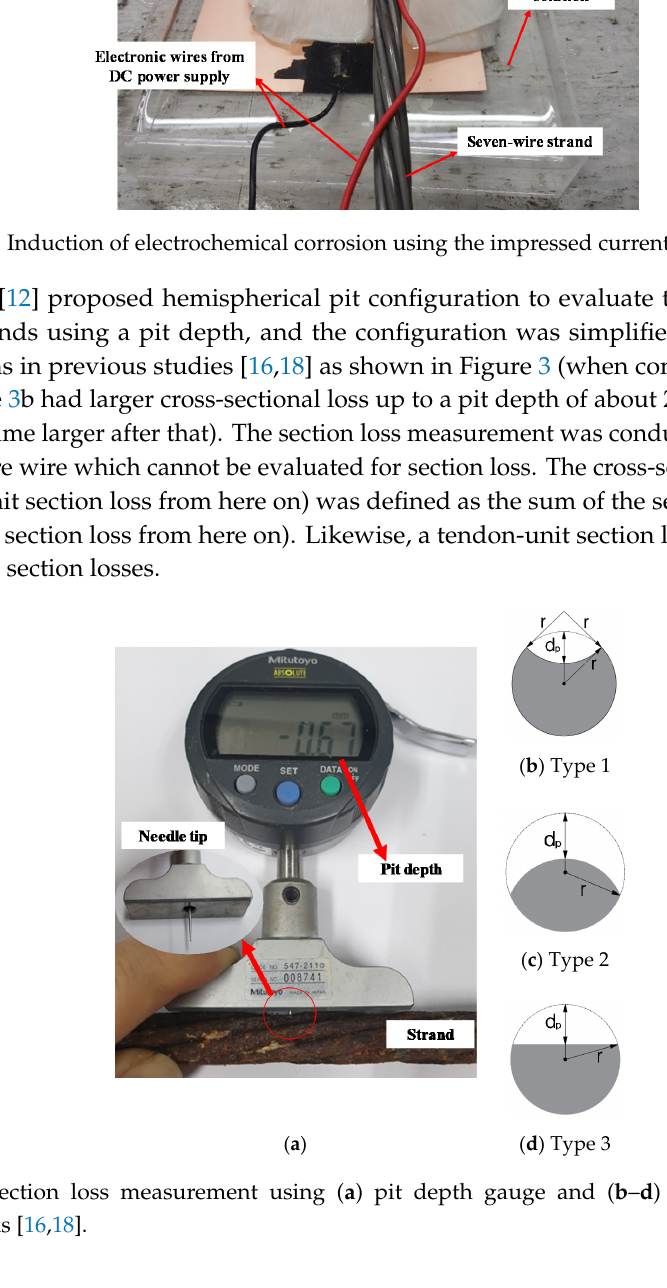
Figure 1. Detailed drawing of the prestressed concrete (PC) beam specimens.